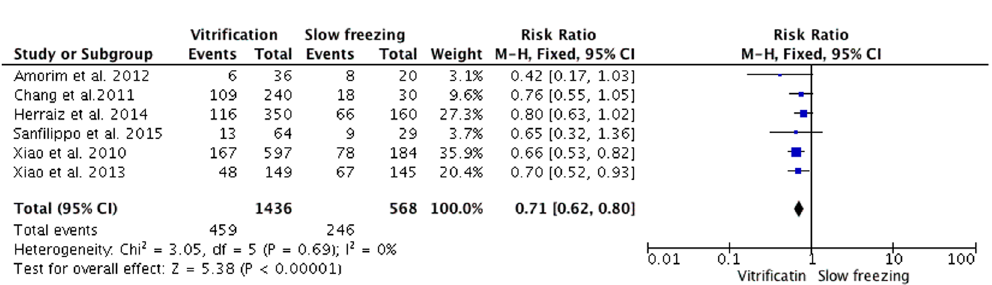
Figure 3. Fixed model of risk ratio with 95% CIs of the DNA fragmentation in primordial follicles: vitrification versus slow freezing.